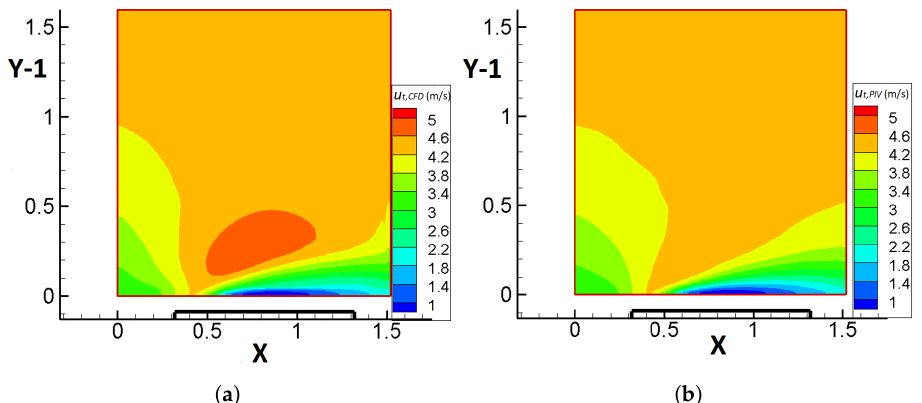
Figure 8. Contours of the total velocities, u t , CFD (m/s) and u t , PIV (m/s), on plane B, extracted by: ( a ) CFD methodology, ( b ) PIV experimental technique. The solid boundary of the cube is denoted by the thick black line, while X and Y are non-dimensional coordinates (non-dimensional distance of 1 corresponds to 1 cube height). Flow is from left to